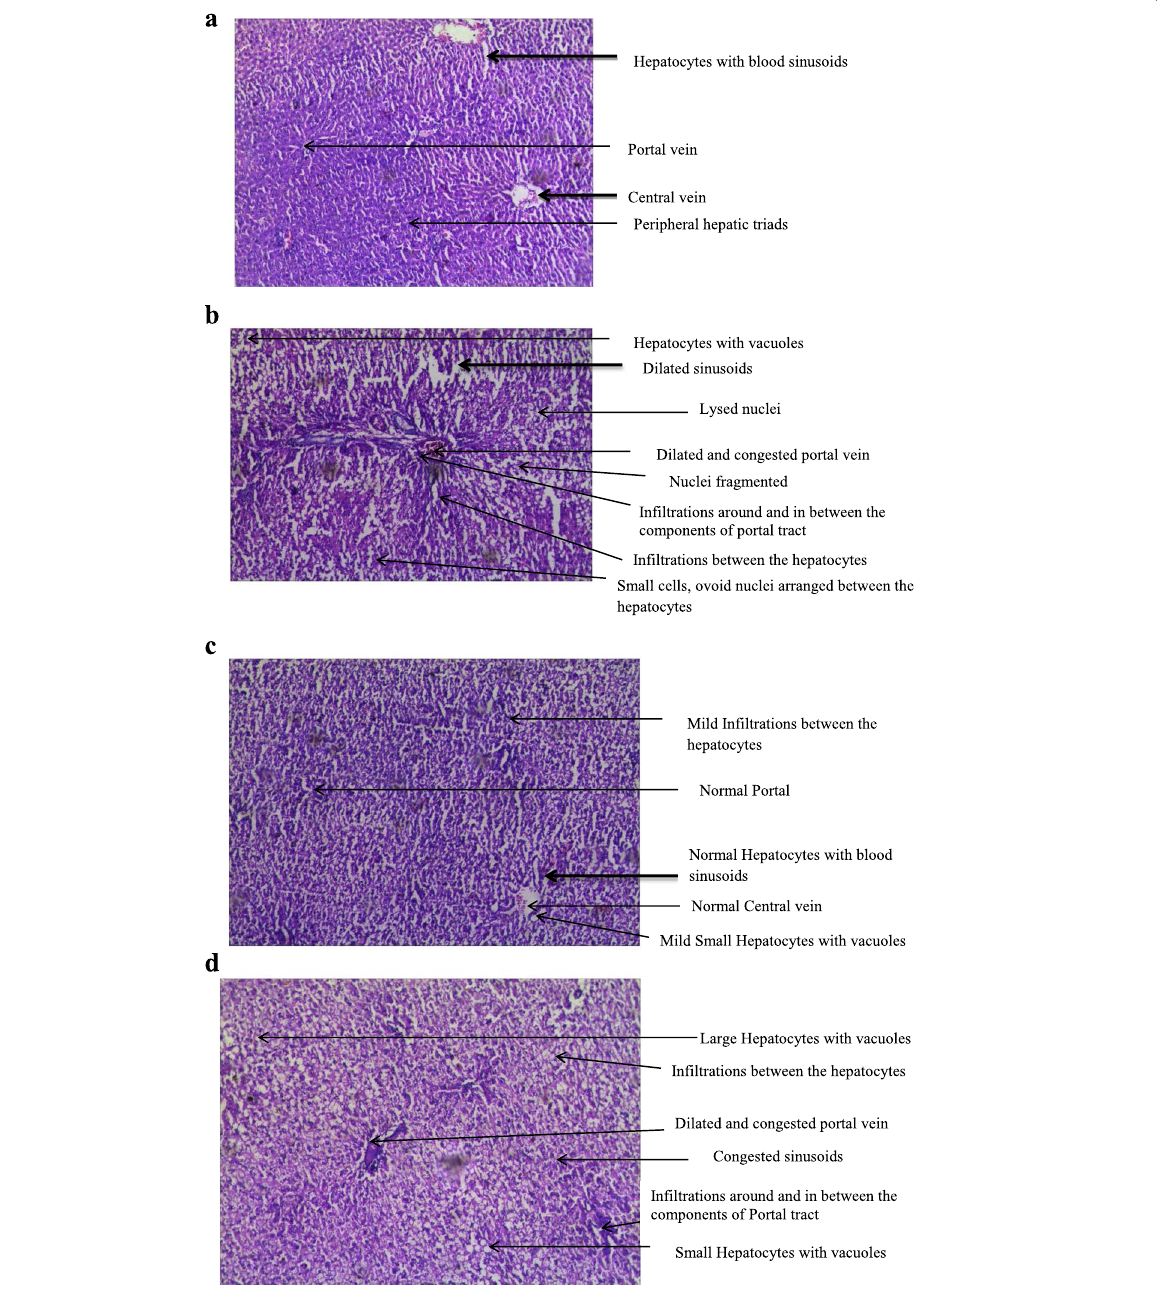
Fig. 6 a Light photomicrographs of liver sections from NC experimental group (H and E staining, Magnification: 10X). b Light photomicrographs of liver sections from DC experimental group (H and E staining, Magnification: 10X). c Light photomicrographs of liver sections from T1 experimental group (H and E staining, Magnification: 10X). d Light photomicrographs of liver sections from T2 experimental group (H and E staining, Magnification: